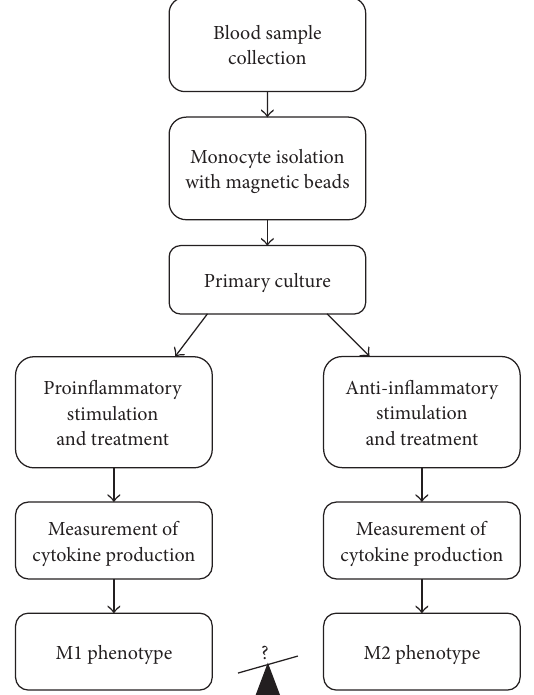
Figure 2: General design of the monocyte/macrophage activation assay.